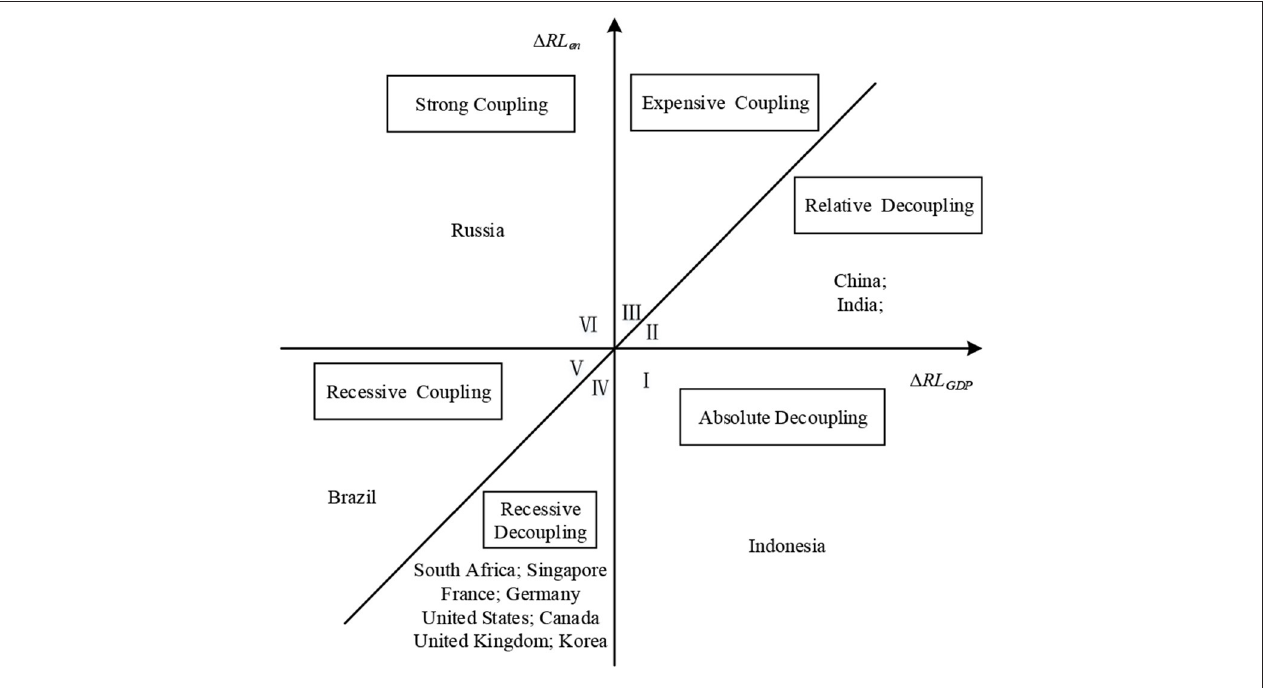
FIGURE 6 | Countries distribution based on resilience decoupling model.